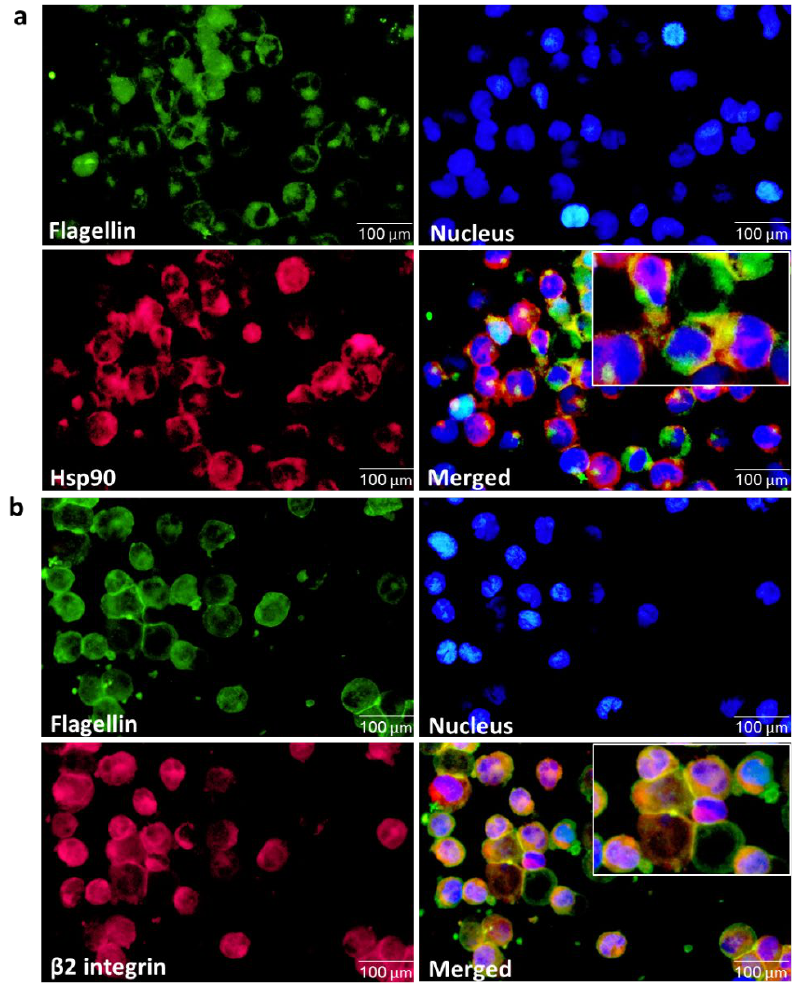
Figure 8. Flagellin colocalizes with β 2 integrin but not with Hsp90 inside the cells. THP-1 cells were stimulated with 1 µM ATRA for 24 h, followed by incubation with 100 ng/mL flagellin for 48 h. The collected cells were then fixed with formaldehyde, permeabilized with Triton X-100 and incubated with the FITC-conjugated anti-flagellin and Alexa 633-conjugated anti-Hsp90 antibodies ( a ) or with the anti-flagellin and Alexa 633-conjugated anti- integrin β2 antibodies overnight at 4 °C ( b ). The cellular distribution of given proteins was detected by fluorescence microscope (×400). Scale bars represent 100 µm.